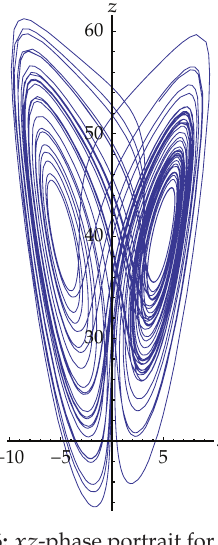
Figure 6: xz -phase portrait for α (cid:8) 0 . 99.